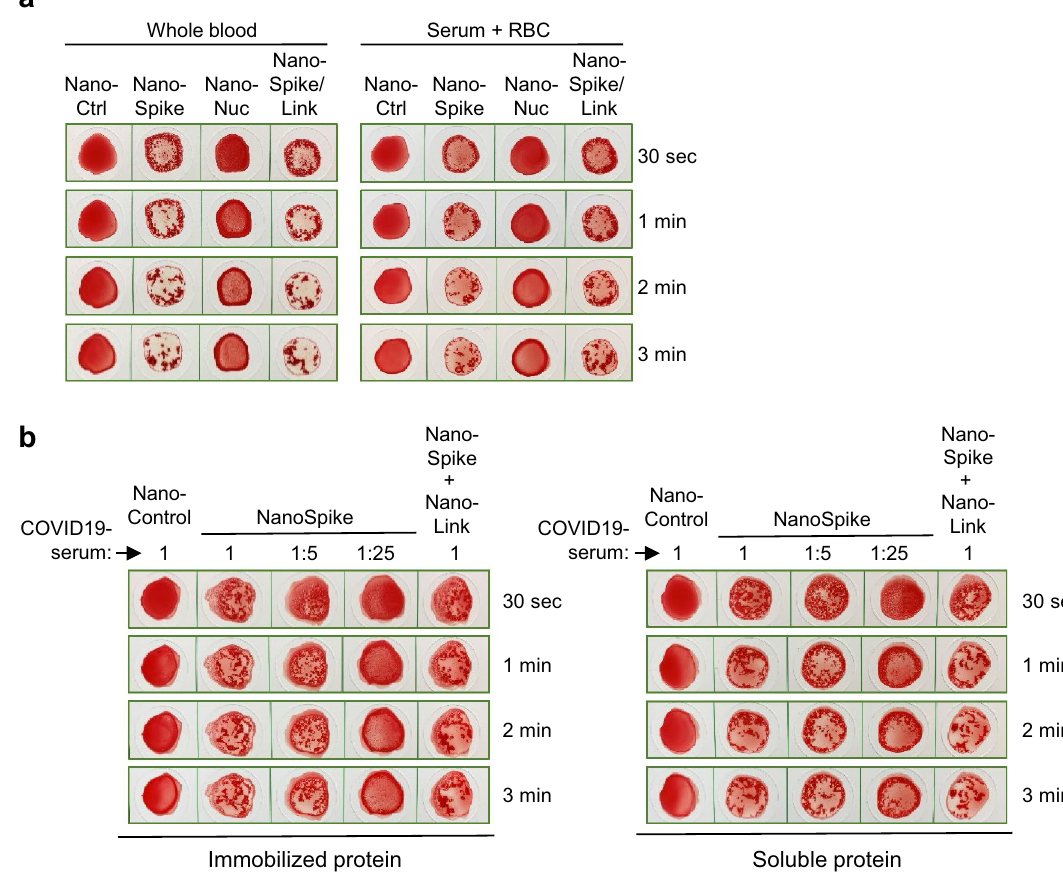
Figure 4. Analysis of whole blood, serum and immobilized proteins in the NanoSpot assay. ( a ) Hemagglutination assay based on samples from a convalescent COVID-19-patient that was treated with indicated proteins. Whole EDTA blood was used directly (left) or serum was isolated and mixed at a physiological ratio with washed RBC from a COVID-19-negative blood group 0 subject (right). ( b ) Hemagglutination assay based on convalescent serum (at indicated dilutions) and recombinant proteins that were either spotted on cardboard (made from 100% extruded polypropylene) and stored at RT overnight (left), or used in their soluble form as described in previous experiments (right). The same cardboard and the same amount of recombinant proteins was used for both